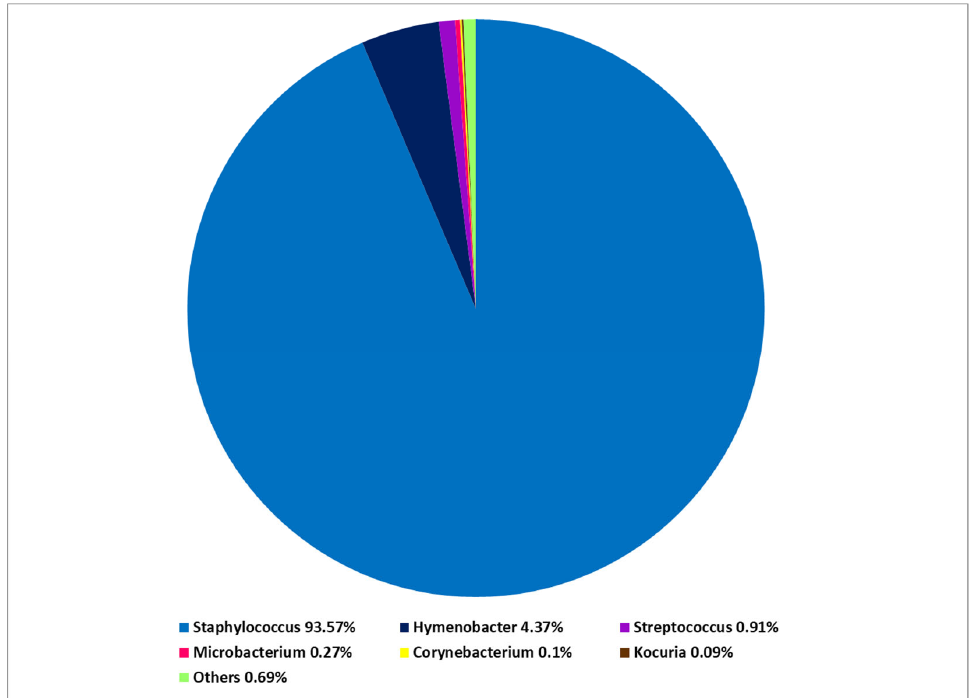
Figure 3. Total composition of the cutaneous bacteria microbiome at the genus level in patients with atopic dermatitis (AD).